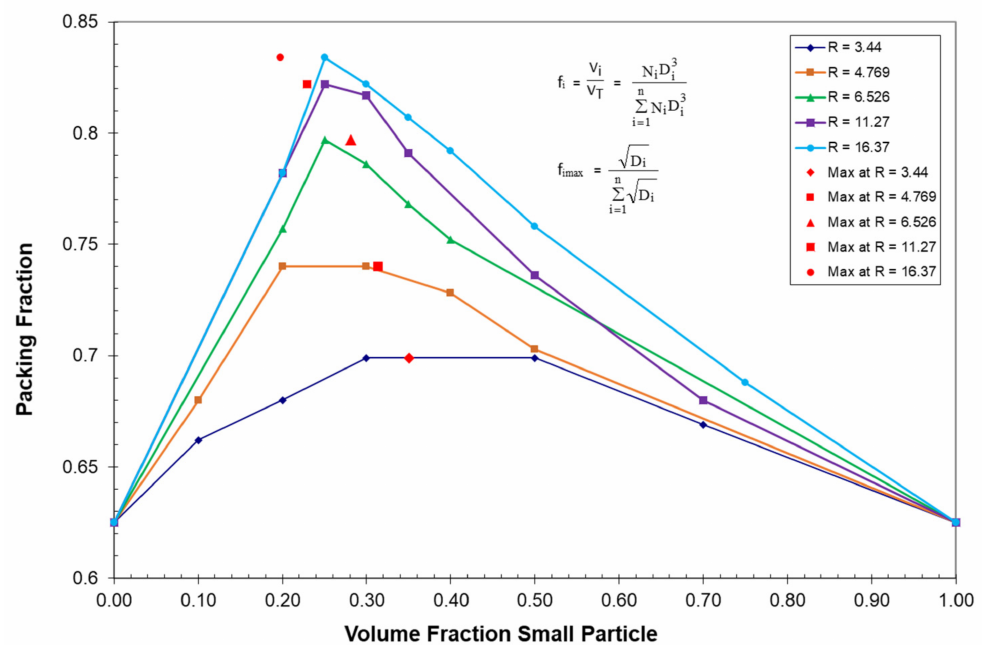
Figure 1. McGeary’s binary particle packing fraction vs. volume fraction small